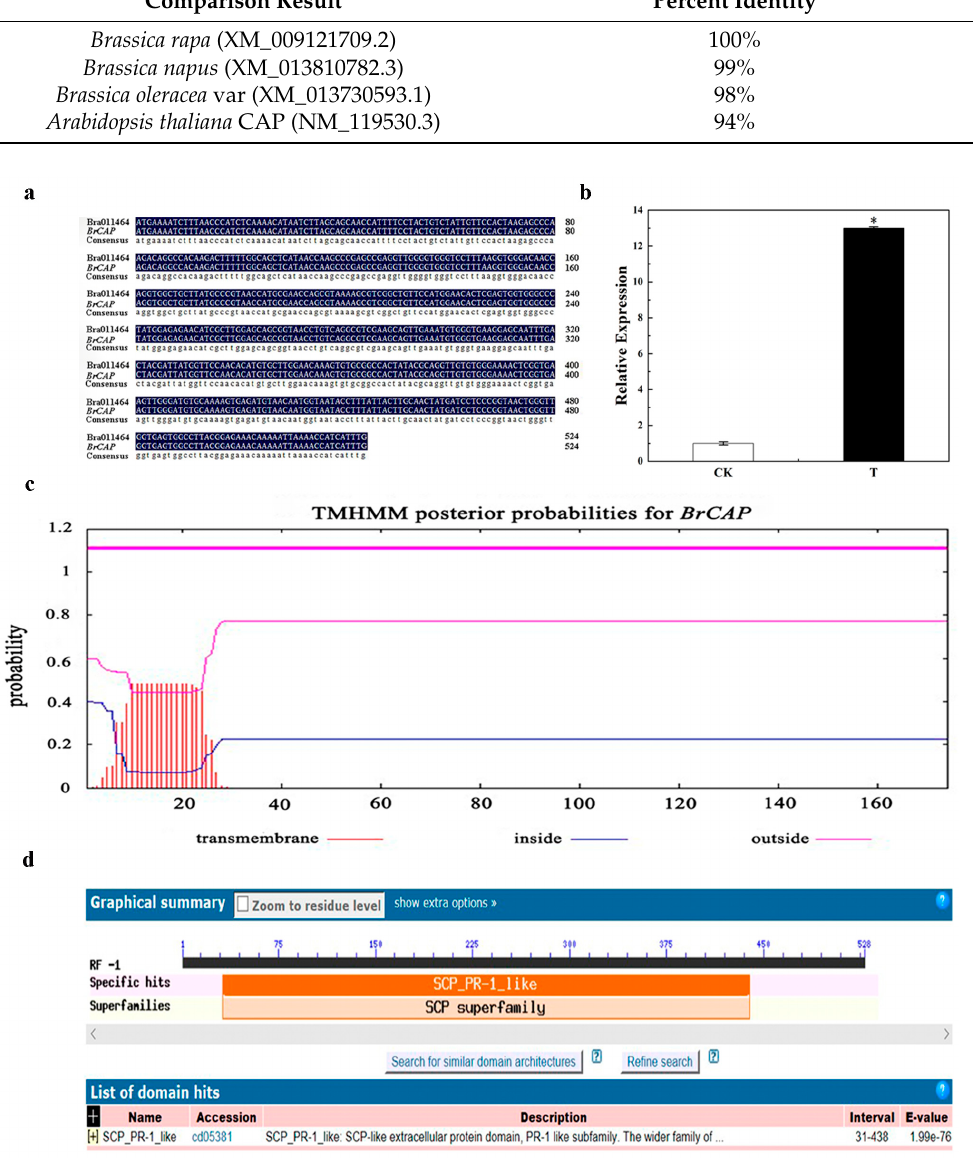
Figure 1. Cloning and bioinformatics analysis of BrCAP . ( a ). Comparison of full-length CDS clone sequences of BrCAP . ( b ). Relative expression of BrCAP in the roots inoculated and un-inoculated with P. brassicae (Note: CK: Control; T: Treatment (inoculated with P. brassicae ). Data represent the mean ± standard deviation ( n = 3). * indicates significant differences at p ≤ 0.05, according to a Student’s t -test. ( c ). Transmembrane domain of BrCAP. ( d ). Prediction of conservative domain in BrCAP. Table 2. Expression level of BrCAP in P. brassicae -inoculated and un-inoculated